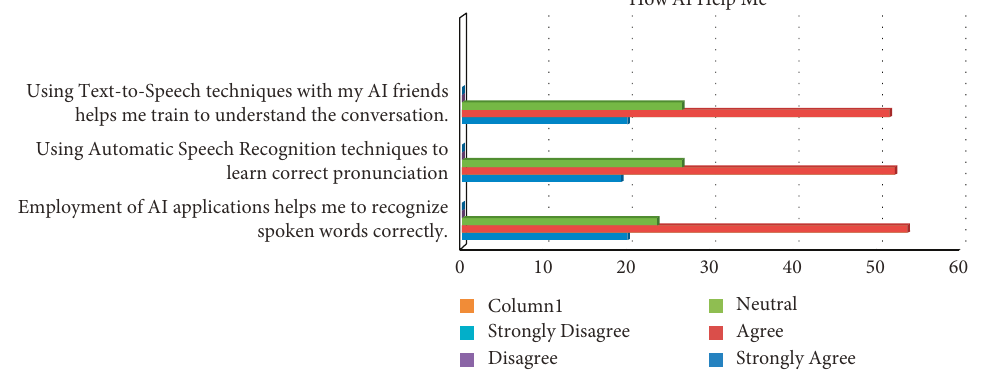
Figure 7: AI features help EFL